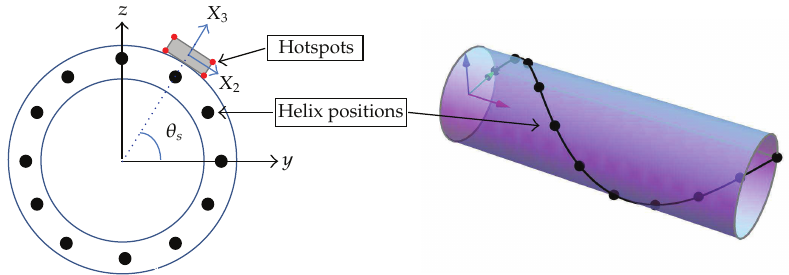
Figure 2: Hotspots and helix positions for fatigue